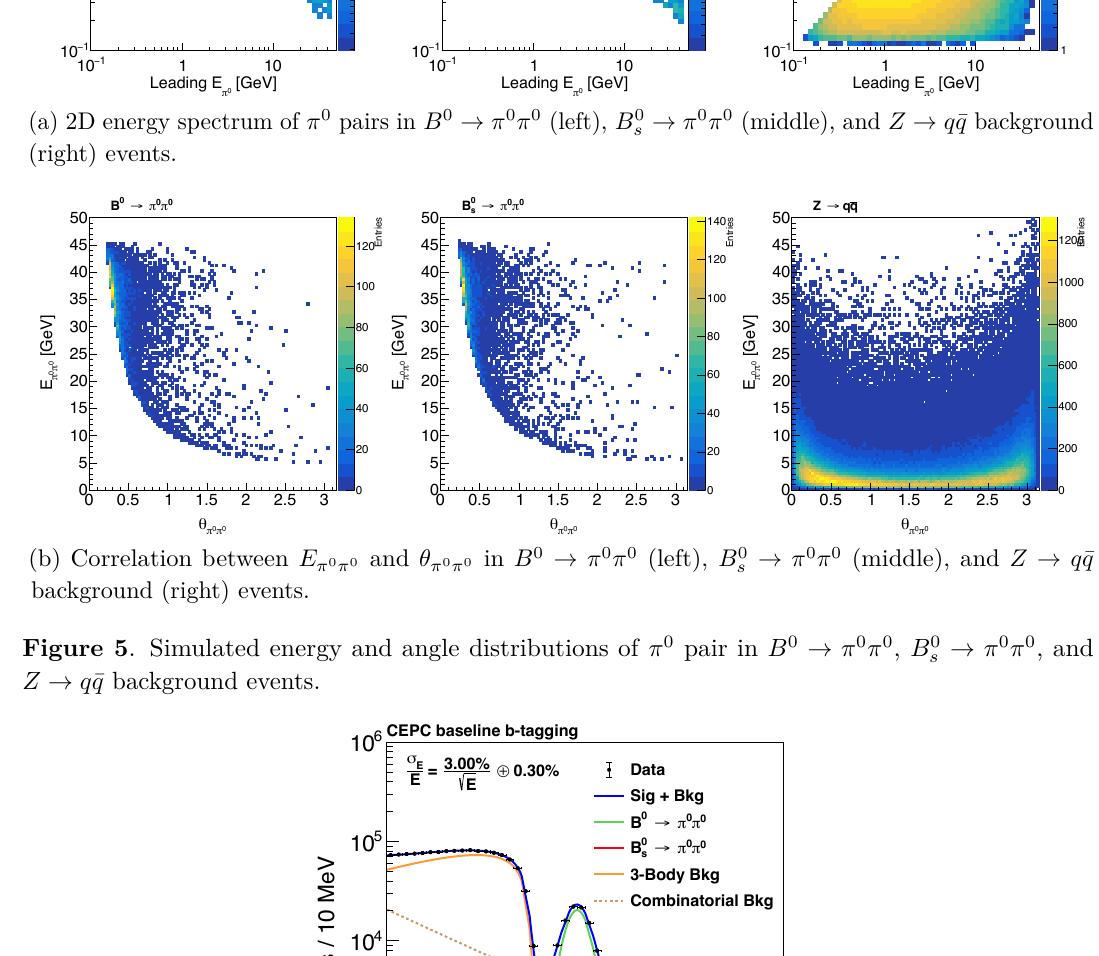
→ π 0 π 0 (middle), and Z → q ¯ q background s